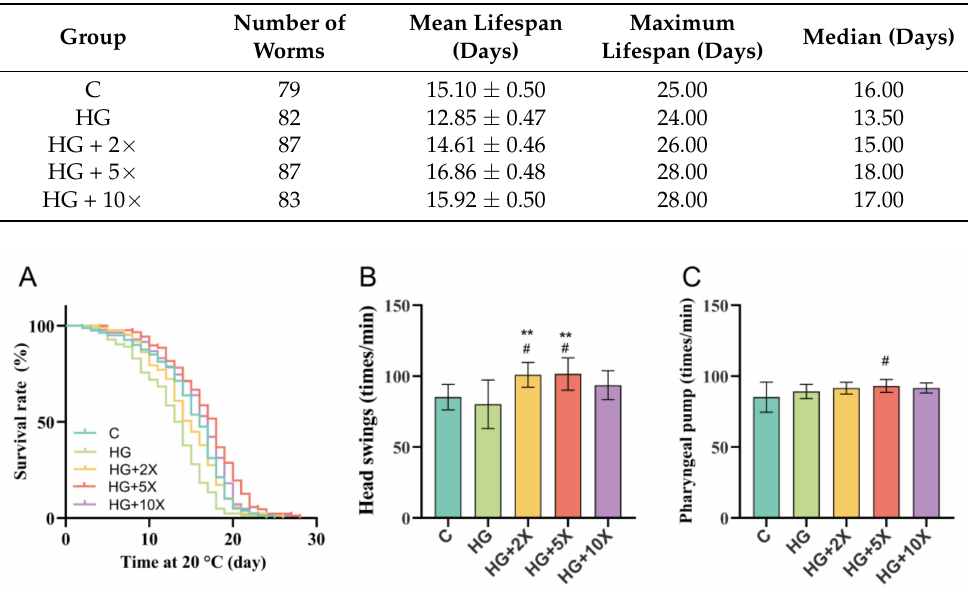
Figure 1. Supplementation with A. muciniphila cell-free supernatant on healthy lifespan in Caenorhabditis elegans. ( A ) Survival curves; ( B ) head swings; ( C ) pharyngeal pump beating. Re- sults are expressed as mean ± SD deviation, and p -values are calculated by Tukey’s test. Compared with the control group, # is significantly different at p < 0.05; compared with the high-glucose group, ** is significantly different at p <